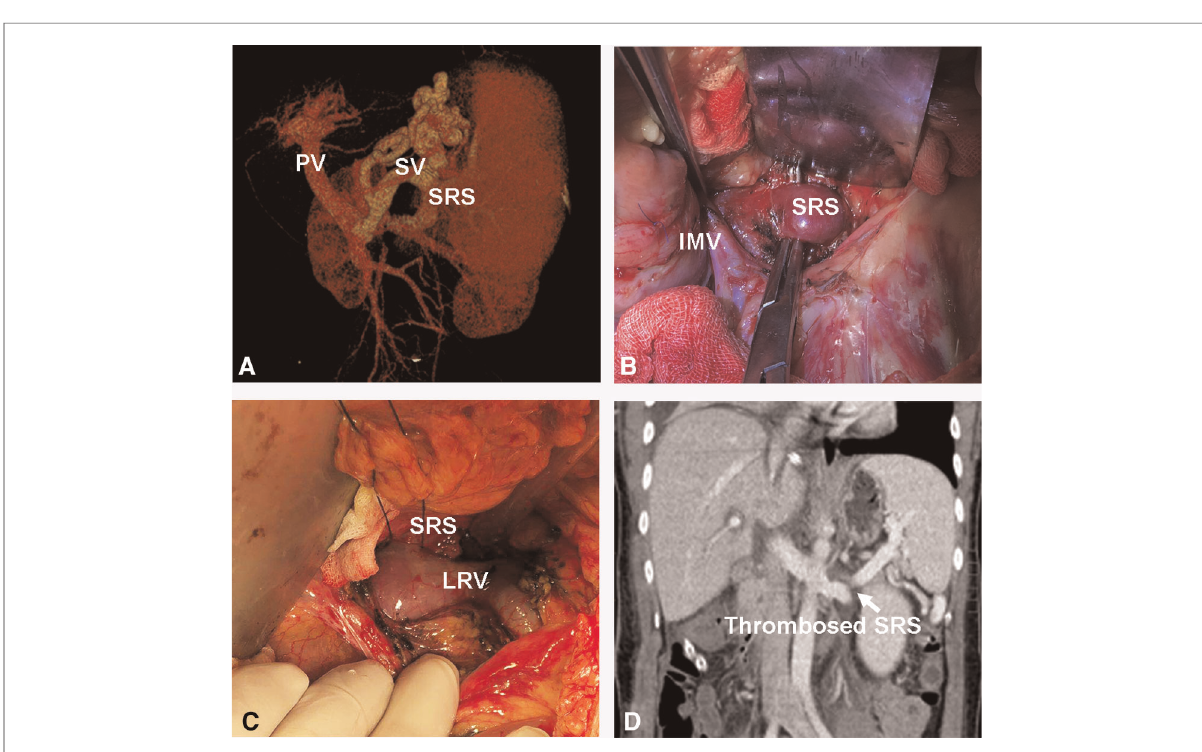
FIGURE 2 Direct ligation of a large SRS. ( A ) Large SRS before transplantation. ( B, C ) Isolation and ligation of large SRS. ( D ) Thrombosed SRS on day 7 post transplantation. SV, Splenic vein; IMV, inferior mesenteric